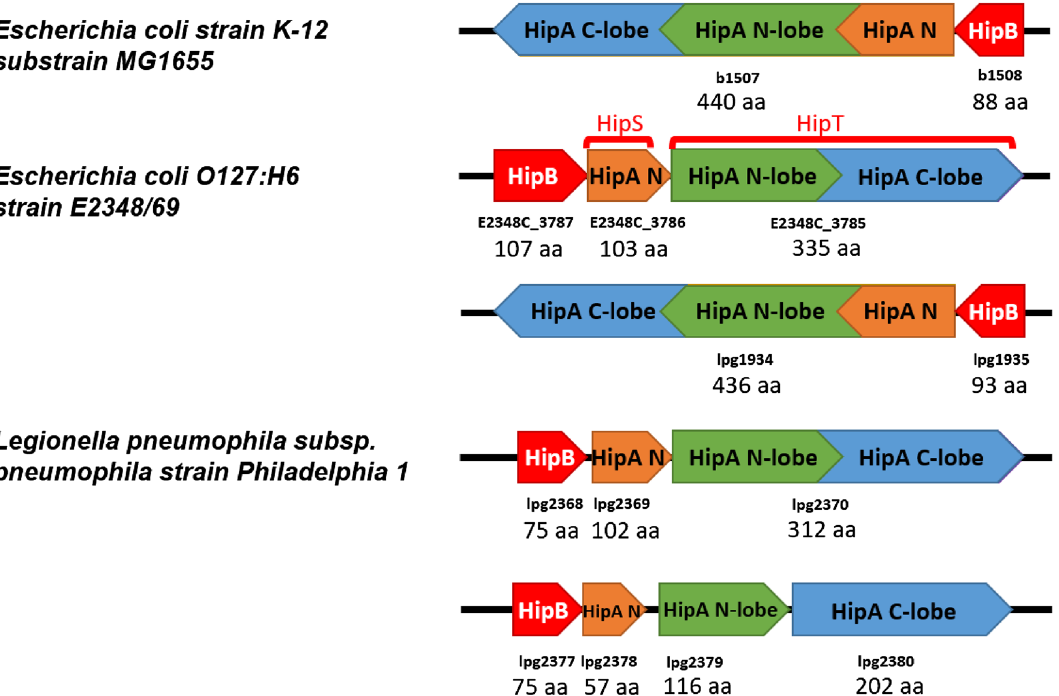
Figure 8. HipA-like modules in different bacteria. Gene loci names and protein lengths are shown below the gene diagrams. The colors represent HipB (red) and the subdomains of HipA (HipA-coupled N-terminal domain—orange, kinase N-lobe—green, kinase C-lobe—blue). The L. pneumophila protein lpg1934 (not shown) has the same gene/domain arrangement as E. coli K12